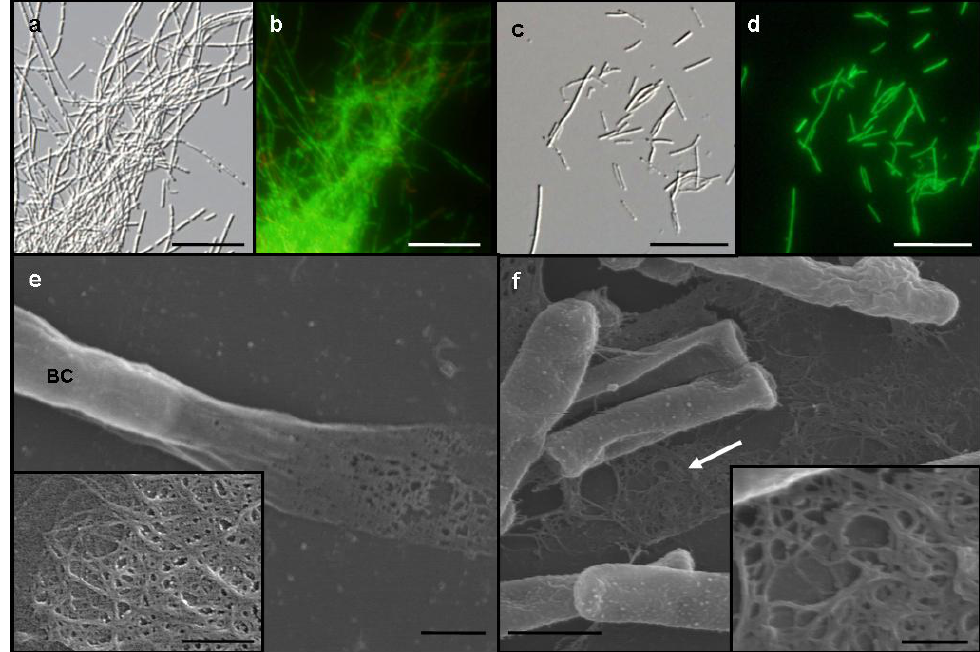
Figure 1. Differential interference contrast (DIC) ( a and c ) and fluorescence ( b and d ) light microscopy and SEM ( e and f ) images, of Leptothrix sp. strain OUMS1 and sheathless mutant (SL) cells and associated structures cultured in − Fe medium for 3 days. ( a ) Dense aggregation of chained cells and a few free cells of OUMS1; ( b ) Green and red fluorescence of these cells after vital staining, green indicating their living state and red indicating dead cells; ( c ) Scattered, non-aggregated, short chains of a few SL cells; and ( d ) Their fluorescence after vital staining; ( e ) OUMS1 cell (BC) and layered fibrils of sheath. Inset: enlarged fibril network; ( f ) Chains of SL cells and secreted network of fibrils (white arrow). Inset: Enlarged network of loosely woven fibrils. Scale bars, 25 µm in ( a )–( d ), 1 µm in ( e ) and ( f ), and 250 nm in ( e ) and ( f